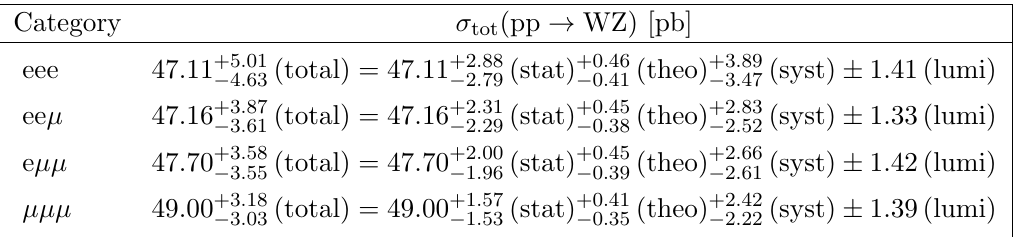
Table 6 . Measured WZ production cross sections computed separately in each of the (cid:13)avour